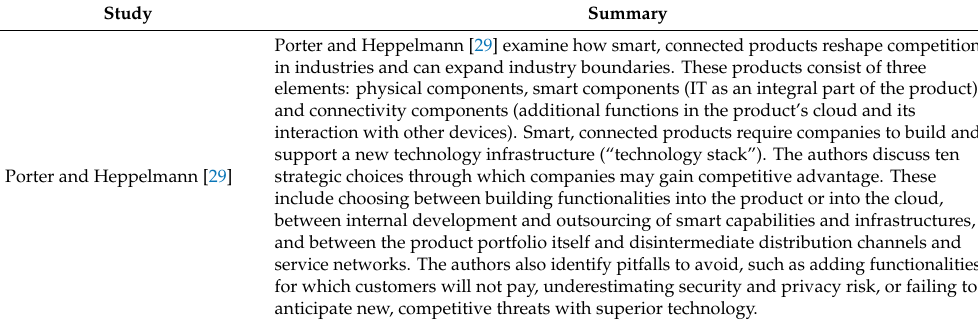
Table 3. Selected papers on digital business models